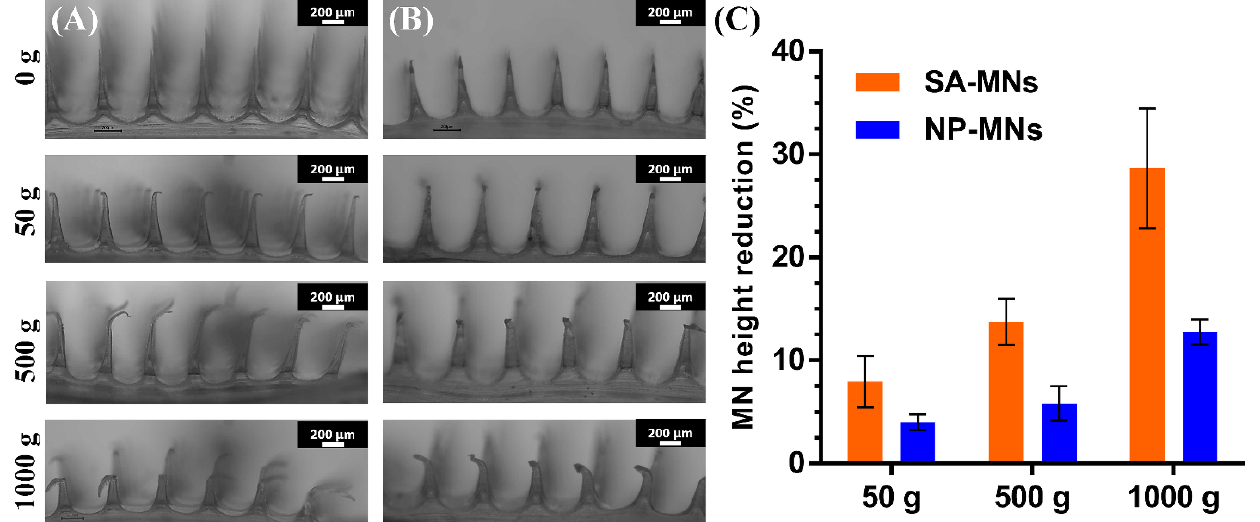
Figure 8. The mechanical strength of SA-MNs and NP-MNs after applying different weights: Optical images of the deformation of ( A ) SA-MNs and ( B ) NP-MNs under weights of 50, 500, and 1000 g, scale bar 200 μ m. ( C ) MN height reduction for MNs after compression: results expressed as means ± s.d., n = 10.